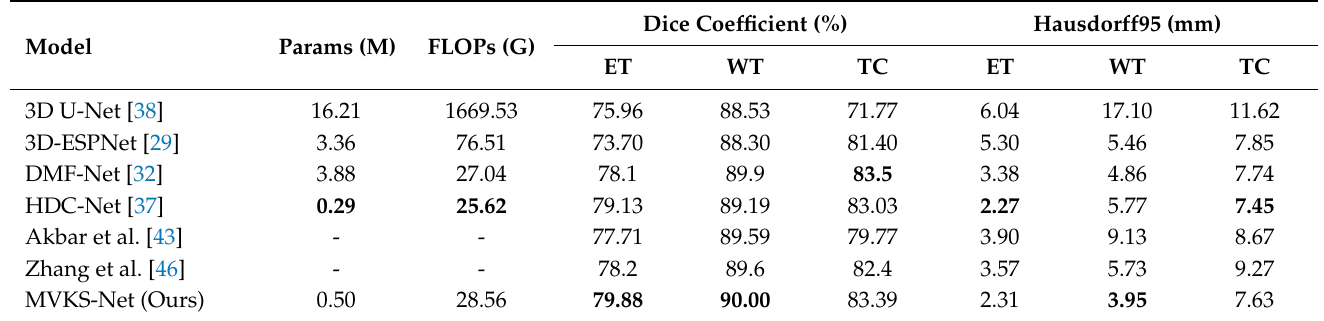
Table 6. Comparison of segmentation effects of various networks on the BraTS2018 validation set. A (-) denotes that the results are not reported.